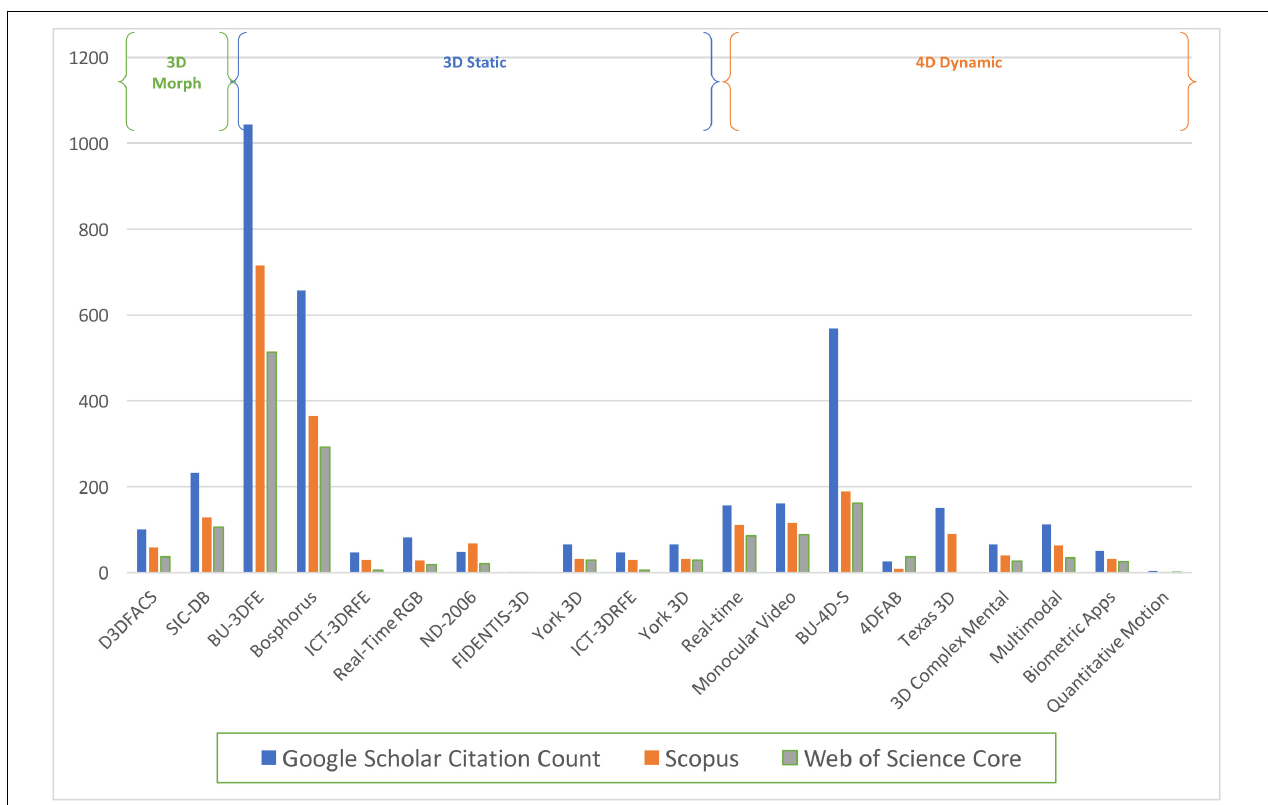
FIGURE 3 | 3D and 4D facial databases publication frequency across Google Scholar, Scopus and Web of Science. Search on 13/02/2020, including count of the original published journal article of each